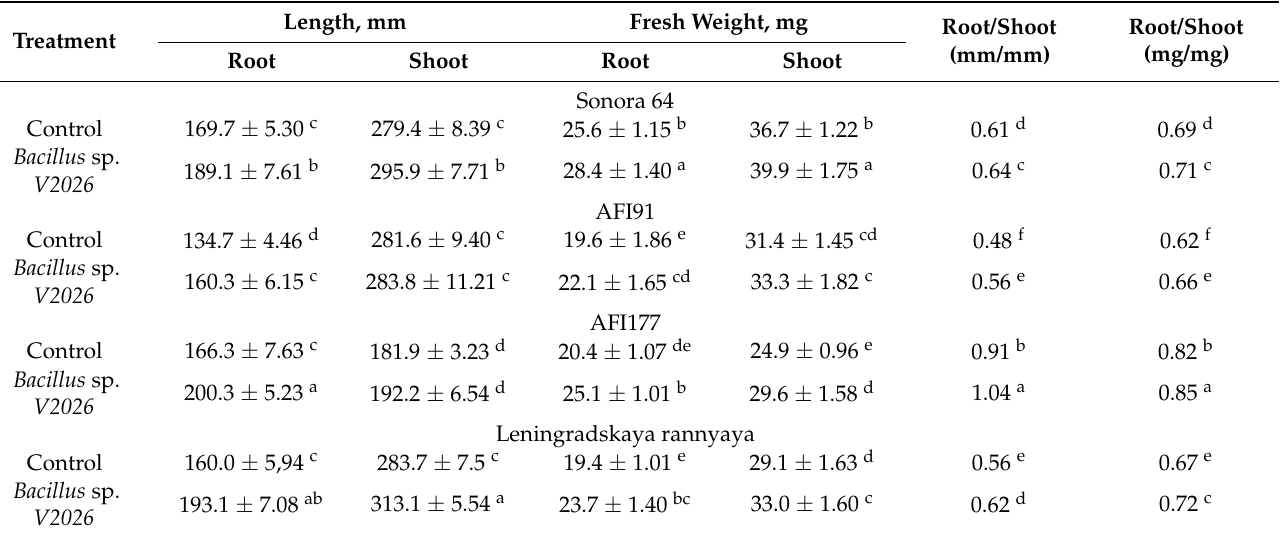
Table 4. Effect of Bacillus sp. V2026 on wheat roots and shoots of early-maturing wheat in hydroponic